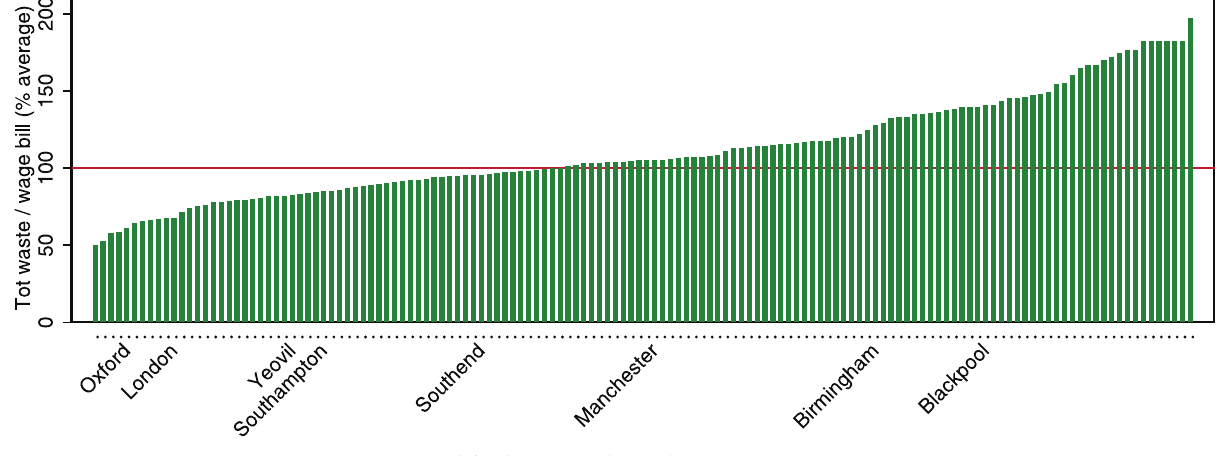
Fig 7. Ranking of cities by waste efficiency. Cities are defined as UK travel to work